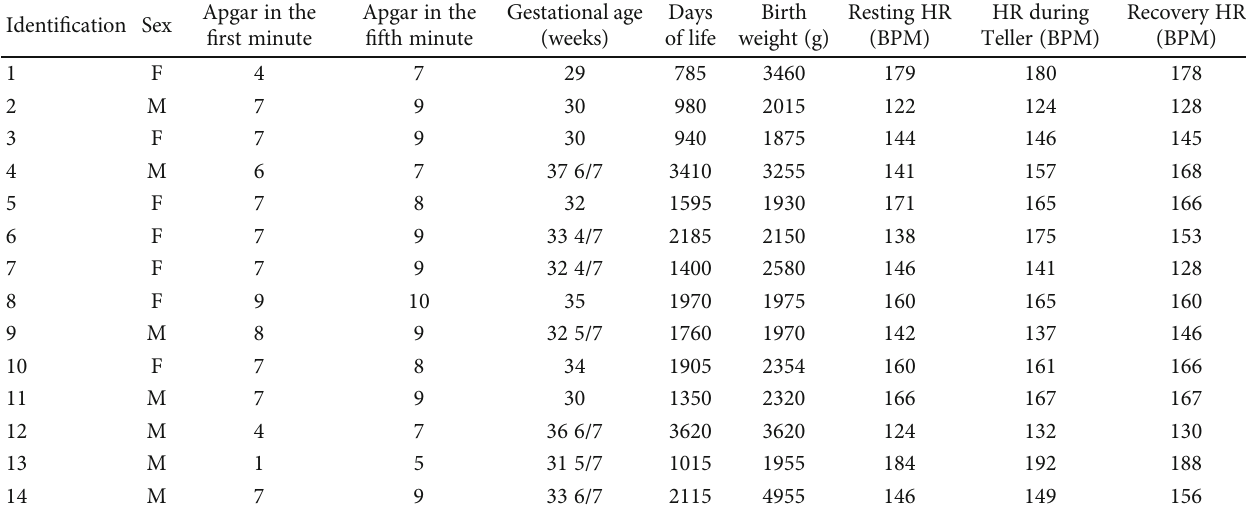
Table 2: Individual sample values.